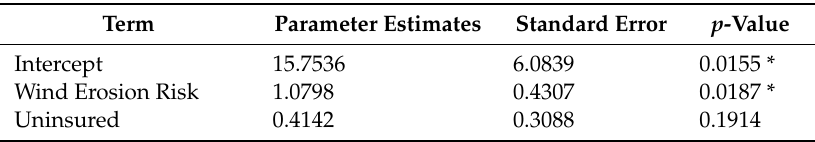
Table 6. Regression Results for AER visits (R 2 = 0.307).